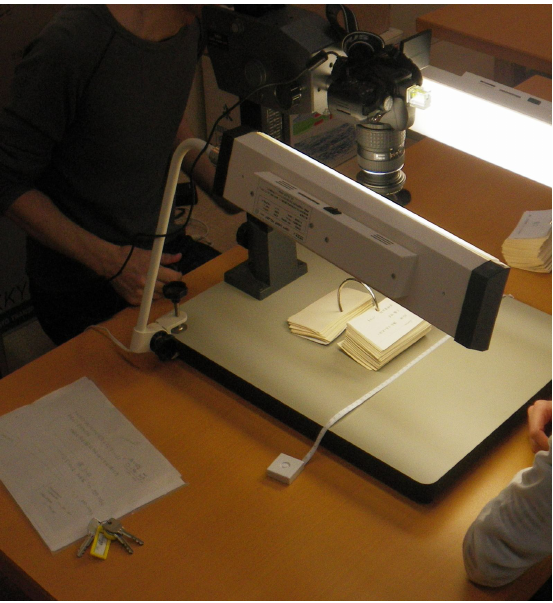
Figure 3: Book catalogue cards being digitally photographed; volunteers were worked in pairs